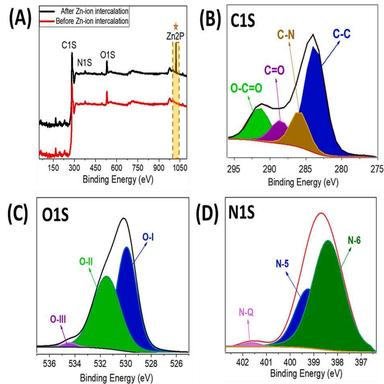
(A) the Surveys of activated carbon before and after Zn adsorption, (B) O1S, (C) O1S and (D) N1S spectra of the activated carbon.